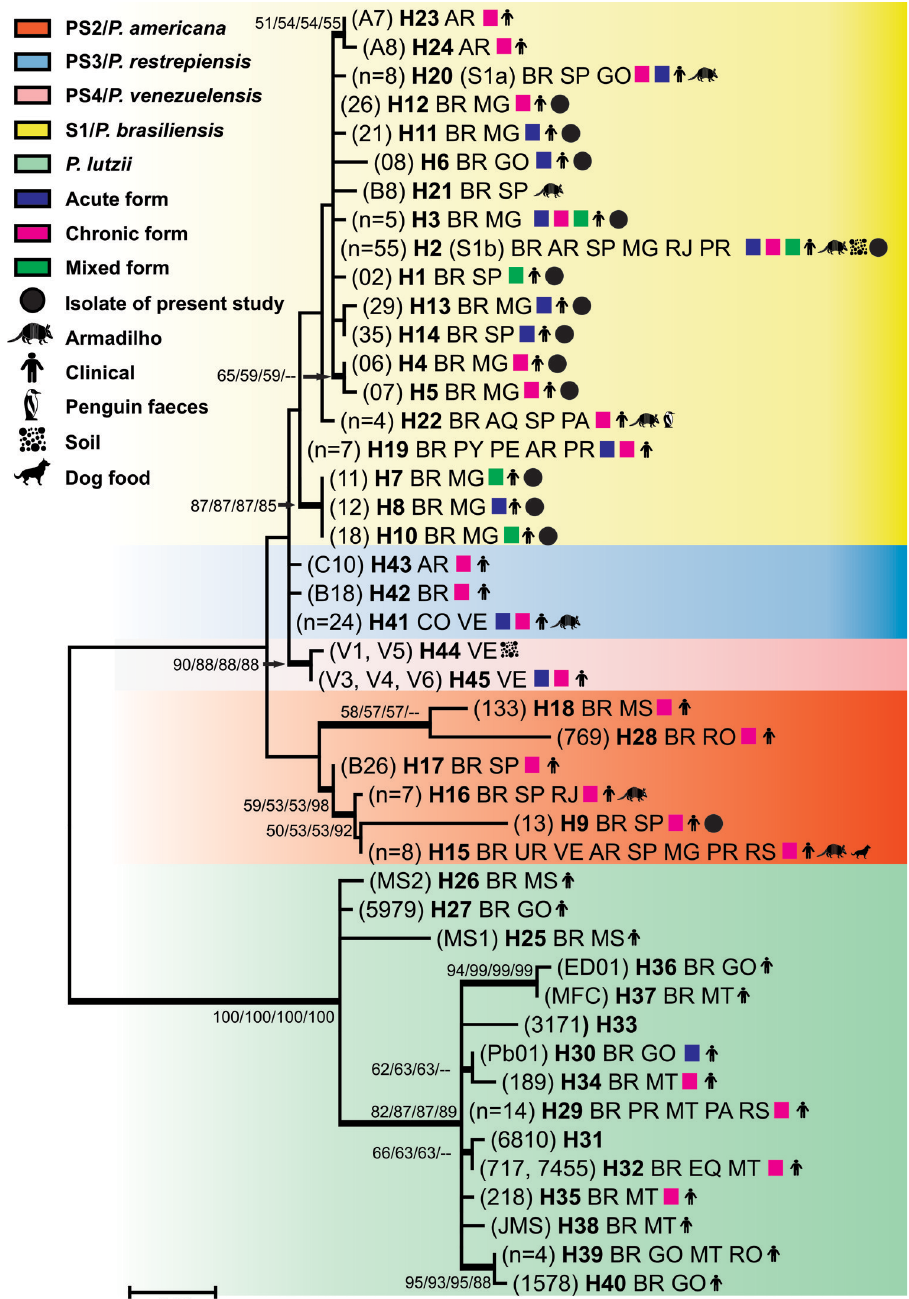
Fig 3. Phylogenetic analysis of 45 haplotipes of Paracoccidioides spp. The phylogenetic analysis was inferred by the maximum likelihood (ML), neighbour-joining (NJ), Maximum Parsimony (MP), and unweighted pair group methods with arithmetic mean (UPGMA) using the concatenated sequences of loci GP43 + ARF. These concatenated sequences presented 45 different haplotypes. The tree with the highest log likelihood (-2206.5961) is shown. The tree is drawn to scale, with branch lengths measured in the number of substitutions per site. The analysis involved 45 nucleotide sequences. The codon positions included were 1st+2nd+3rd+Noncoding. There were a total of 814 positions in the final dataset. Evolutionary analyses were conducted in MEGA7. The numbers at each branch indicate bootstrap values > 50% based on 1,000 replicates by each of the three (ML/NJ/MP/UPGMA) algorithms which presented similar topologies. The five especies of Paracoccidioides are marked with different colors. The haplotypes are described according to the names or numbers of isolates which compose the haplotype. When the number of isolates is less than or equal to three all isolates are described in parentheses. When the number is more than three is cited the number